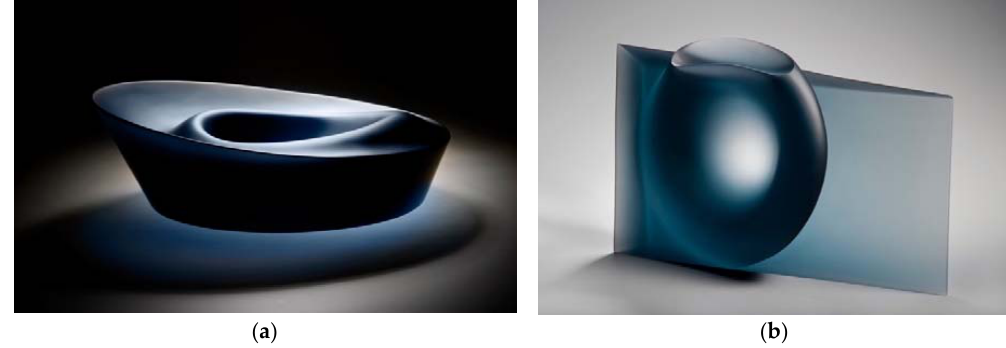
Figure 9. Ashraf Hanna. Photographs by Ester Segarra, courtesy of the artist. ( a ) Ripple Series, Blue Bowl Form, cast glass, dimensions 11 × 33 × 31 cm. ( b ) Blue Vessel Form, 2014, cast glass, dimensions 32 × 48 × 10 cm.